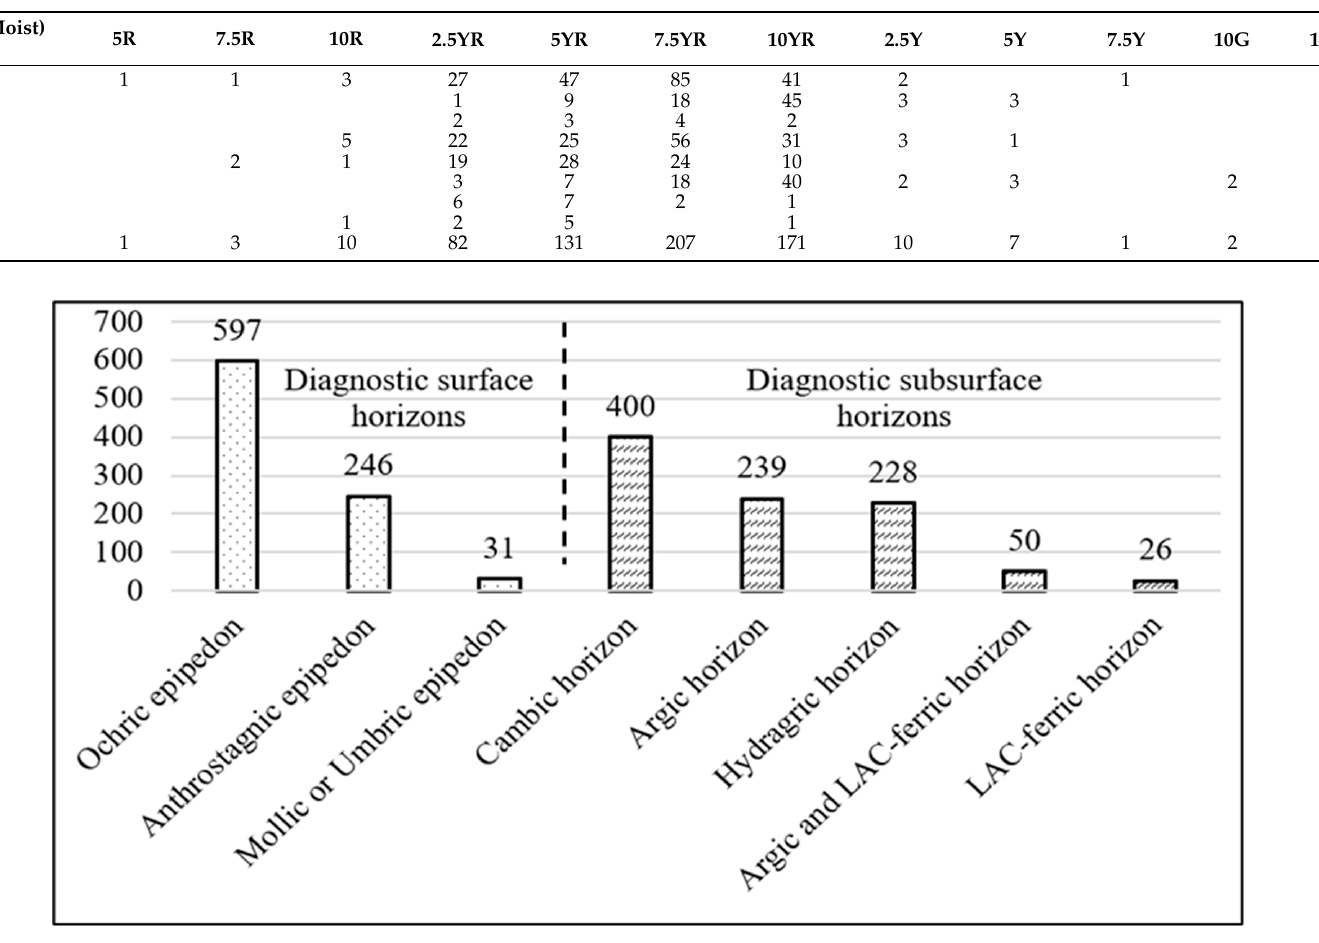
Figure 5. Distribution of the number of diagnostic horizons in the RGB images used in this study.